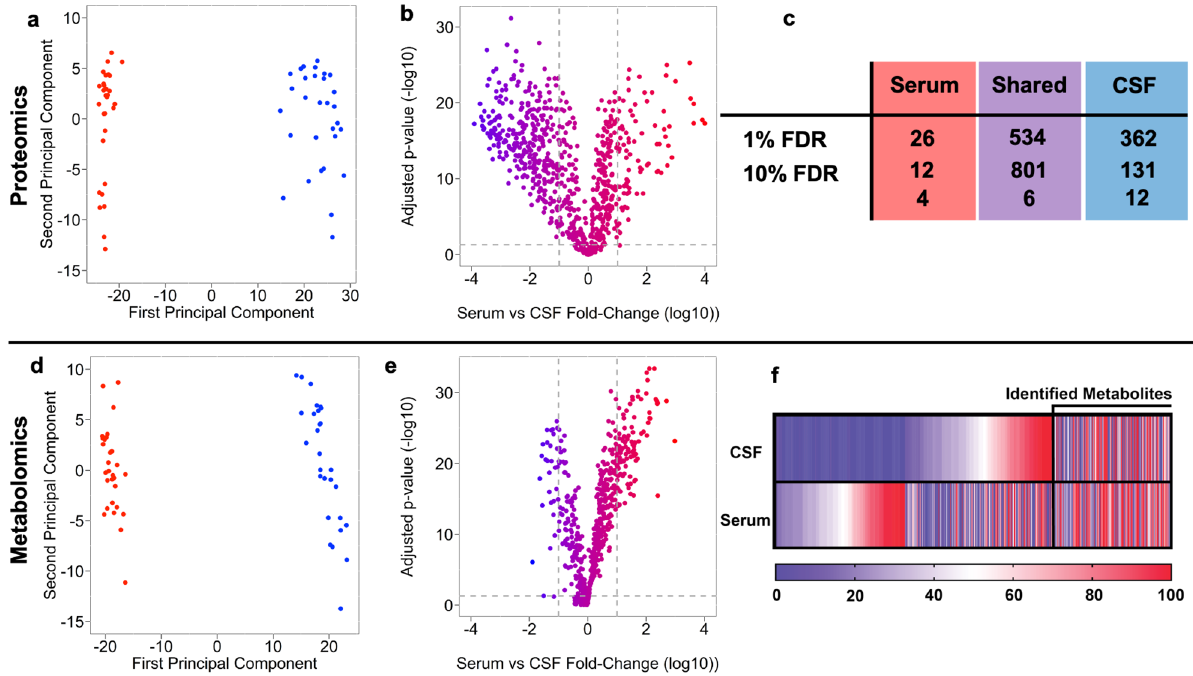
Figure 2. ( a ) Principal component analysis of proteomics data serum proteins (red) and CSF proteins (blue) where each point is a sample. ( b ) Volcano plot of proteomics data where the log 10 of each protein’s intensity versus − log 10 corrected p-value the vertical dashed grey lines represent a +/− tenfold change and the horizontal dashed line is p = 0.05. ( c ) Table describing how the proteins included in the analysis vary by FDR rate. ( d ) Principal component analysis of metabolomics data. ( e ) Volcano plot of metabolomics data. ( f ) Heatmap of metabolites covered in the analysis, metabolites right of the black line represents the metabolites positively identified. rThe 0–100 scale on the heatmap represents normalized percentage of being detected in either CSF or